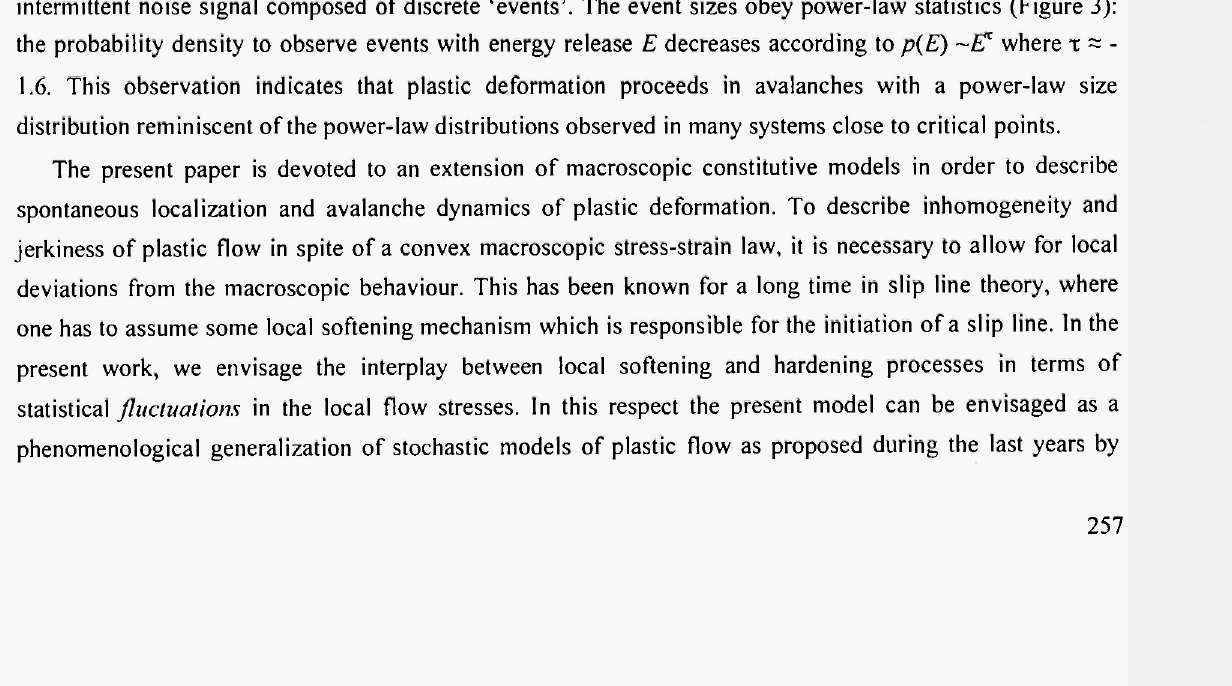
Heterogeneity of slip in spite of macroscopically stable deformation is illustrated in Figures 1 and 2. Figure 1 shows a scanning electron micrograph of the surface of a Ni single crystal deformed into hardening stage II (after Meißner et al. 191). The surface exhibits a lamellar morphology; the direction of the lamellae (the^ direction in Figure 1) corresponds to the intersection of the surface with the slip plane. Normal to this direction, the surface exhibits a rough random profile. Such random surfaces can be characterized in terms of their fractal dimension /10/. The fractal dimension of the surface of a deforming Ni single crystal was determined by Meißner et al. from such micrographs taken at different strains. It was found that the fractal dimension increases during a strain interval of a few percent from two (flat surface) towards a constant value of about 2.5 (Figure